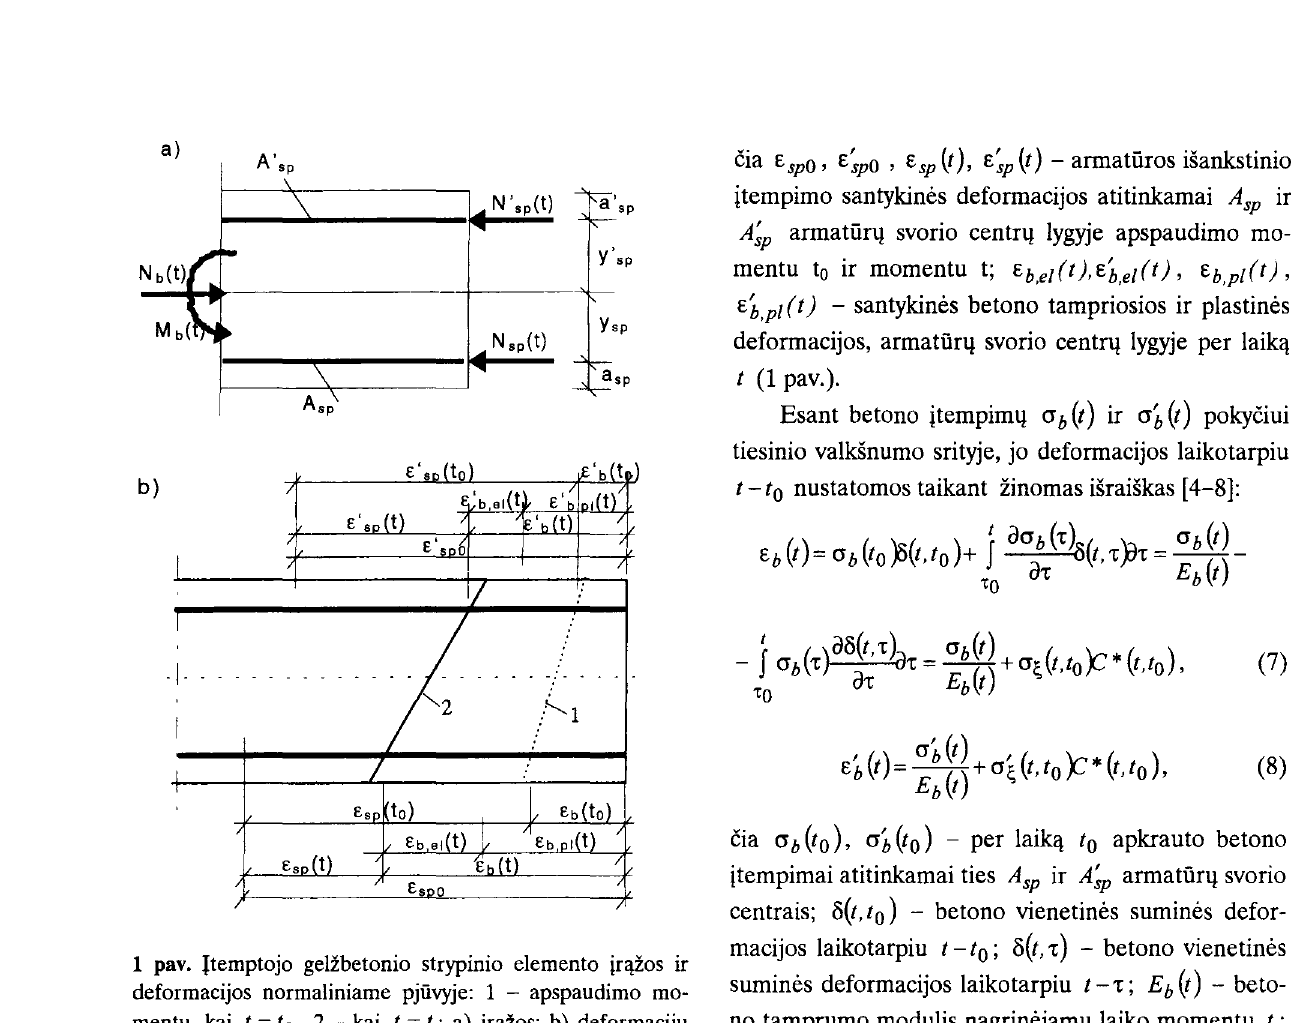
Fig 1. Forces and strains in cross-section of prestressed concrete linear member, 1 - at the moment of prestress when t = t 0 and 2- at the moment when t = t: a) forces; b) strain